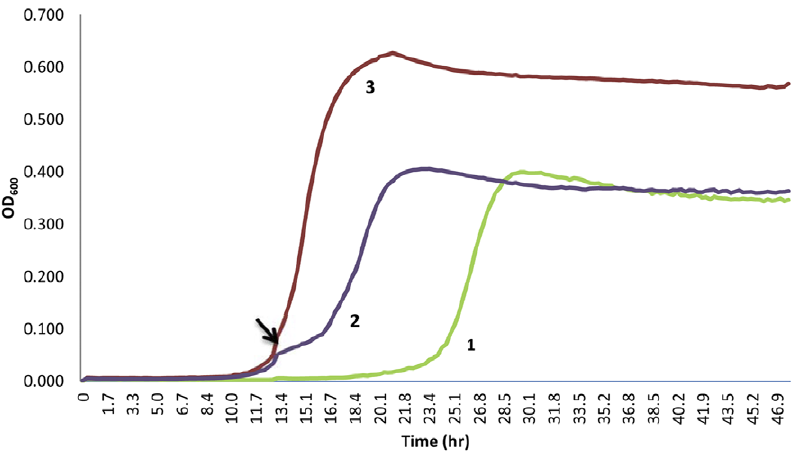
Figure 5. Induction of daptomycin resistance in Paenibacilluslautus LC231. LC231 was cultured in TSB supplemented with 1.25 mM CaCl 2 and 4 m g/ml daptomycin added from start (zero time point) (1) or early log phase (2). Growth was compared to growth control with no drug (3). Arrow represents the time point at which daptomycin was added during early log phase.